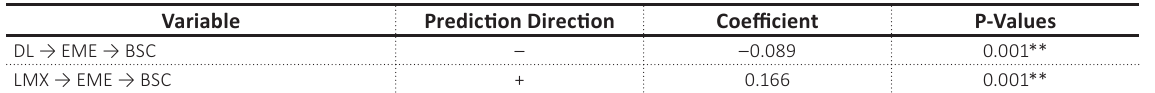
Table 4. Multiple linear regression: Testing mediation effect of employee engagement